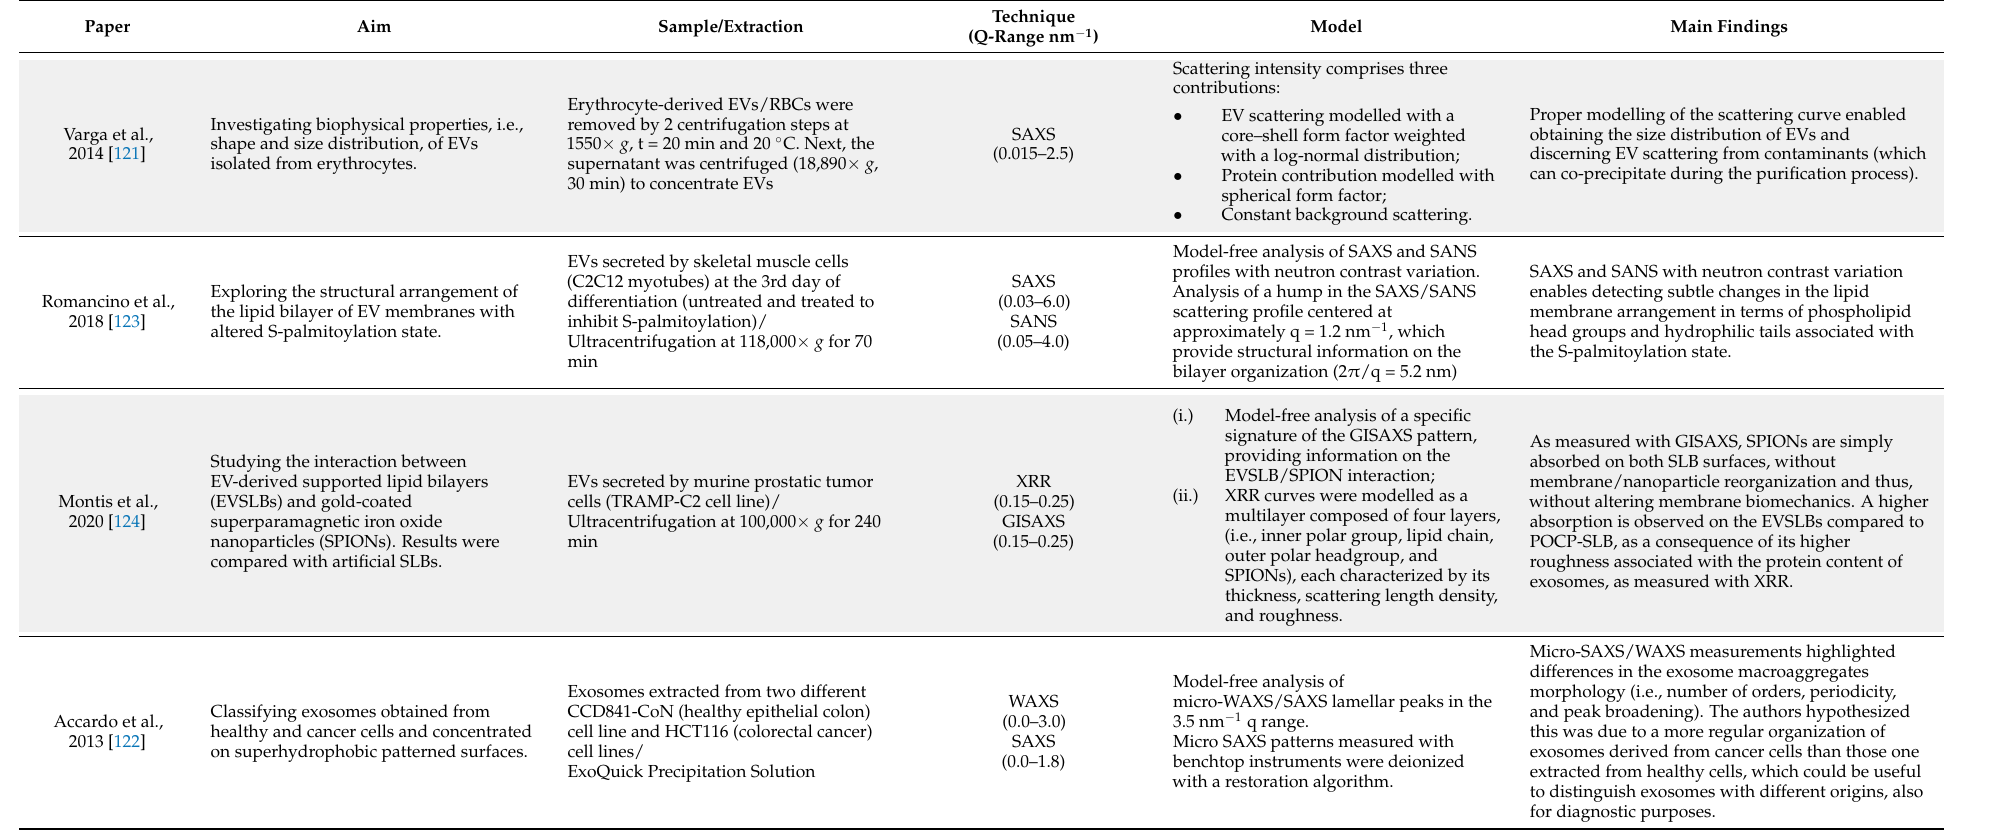
Table 2. Summary of selected papers in the literature studying EV structure with SAS and diffraction